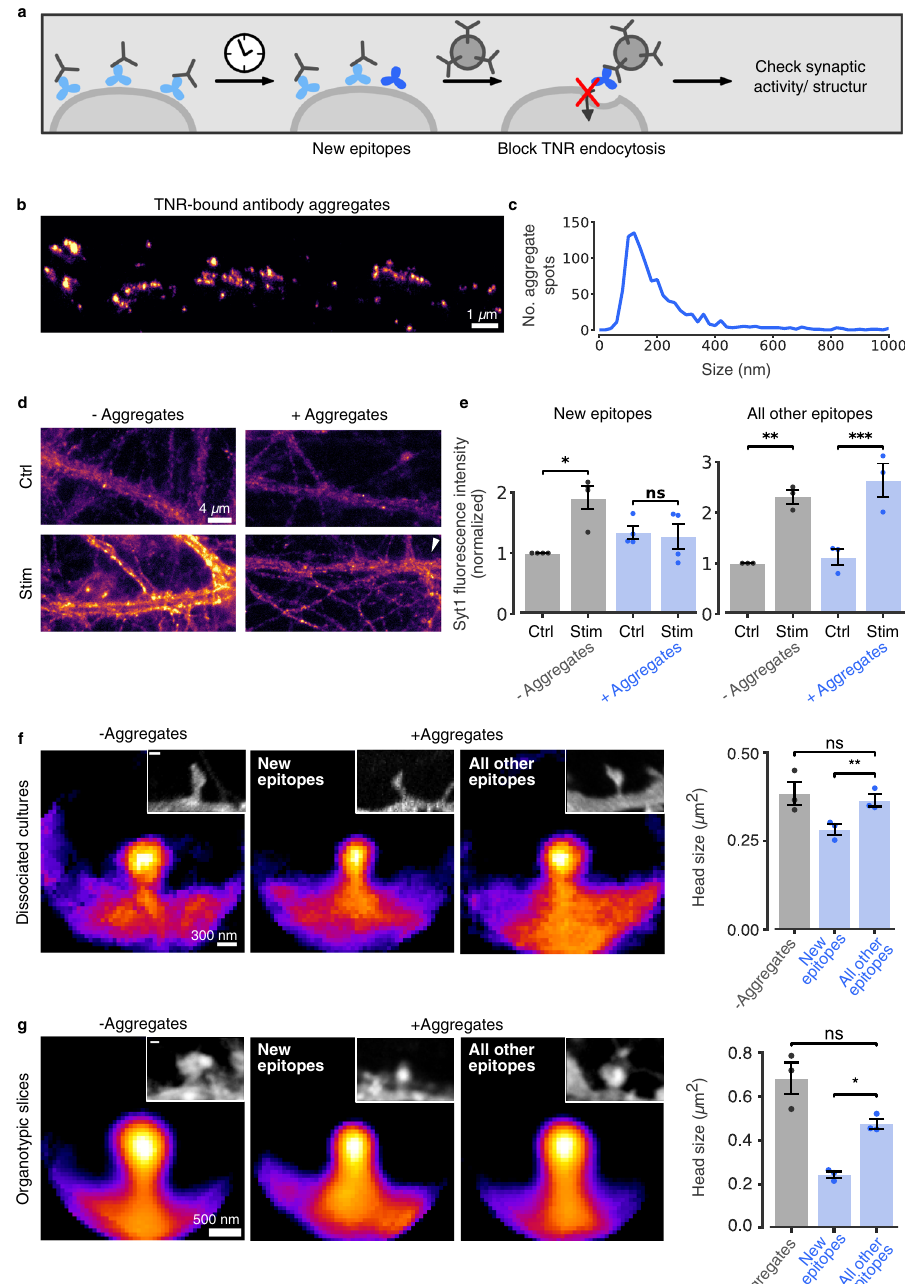
TNR epitopes, neurons were incubated with antibodies conjugated to the fl uor- escent dye Atto647N, Atto550 or STAR580 (custom-made; clone 619 ; Synaptic Systems, Göttingen, Germany) diluted 1:500 in their own cell media, for 1h. The labeling was performed after either 0, 2, 4, 6 or 12 h post-blocking. After labeling, the neurons were fi xed either immediately, or after a further incubation of 6 or 12h, in their original culture media allowing for epitope internalization. In some experiments, the surface-bound antibodies were stripped at the end of the blocking-labeling assay. These details are denoted in the fi gure legends. For the 2-color STED experiment comparing old and newly-emerged TNR epitopes (Supplementary Fig. 17), the blocking step was performed with STAR580- conjugated TNR antibodies. As a control for unspeci fi c uptake or binding of antibodies, neurons were incubated with 1:500 Atto647N-conjugated goat anti- mouse IgG (#610-156-121 S; Rockland,